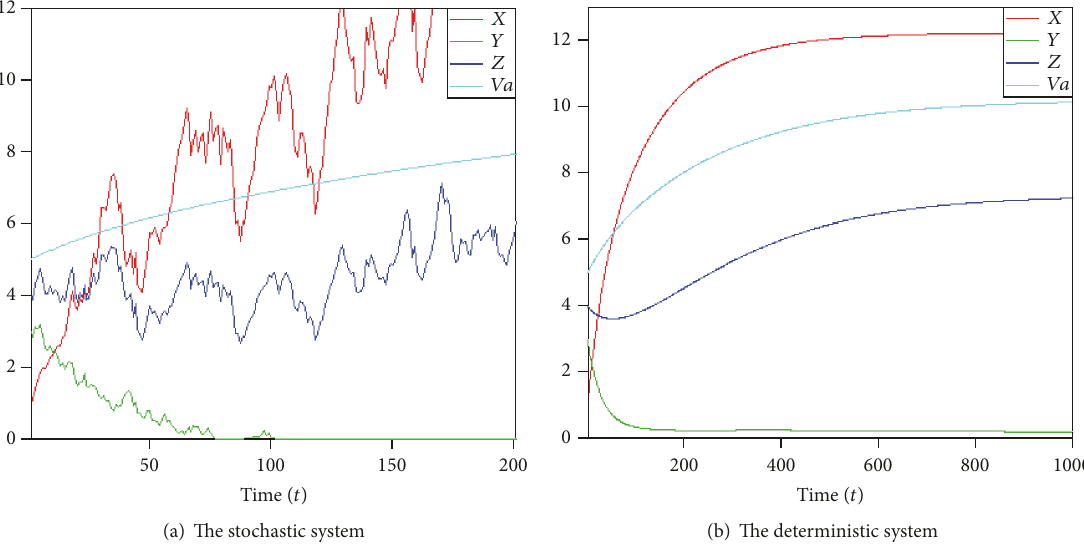
Figure 1: Computer simulation of the path 𝑋(𝑡),𝑌(𝑡),𝑍(𝑡),𝑉 𝑎 (𝑡) for models (a) (3) and (b) (2), for parameters of Example 14, and (𝑋(0),𝑌(0),𝑍(0),𝑉 (0)) = (2,4, 3,5) 𝑎